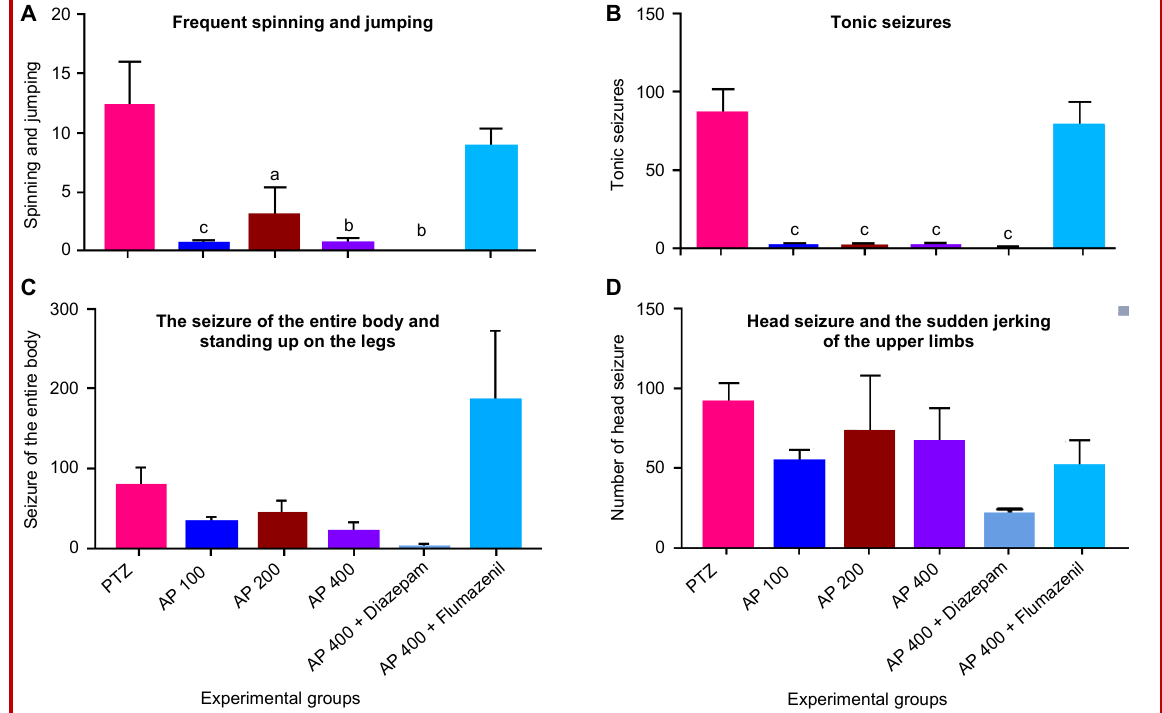
Figure 2: Comparison of the frequencies of repeated spinning and jumping (A), tonic seizures (B), seizures of the whole body, and rearing (C) as well as the frequency of head seizures (D) between groups; * significant difference compared to pentylene- tetrazole group ( a p<0.05, b p<0.01 and c p<0.001); AP = A. persica